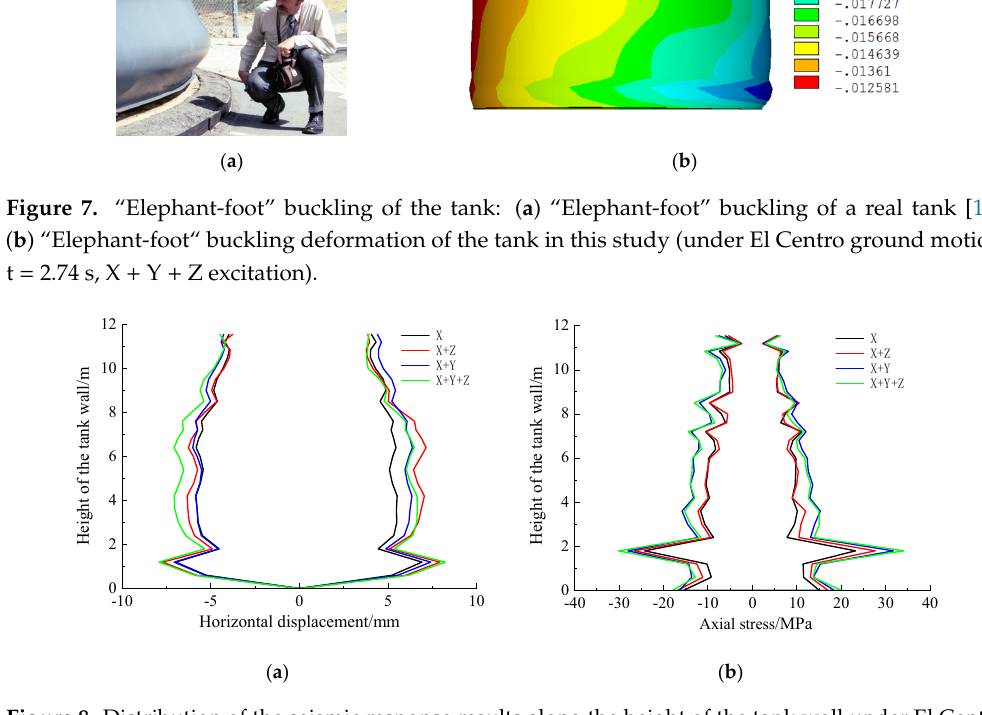
Figure 8. Distribution of the seismic response results along the height of the tank wall under El Centro ground motion: ( a ) horizontal displacement; ( b ) axial stress.